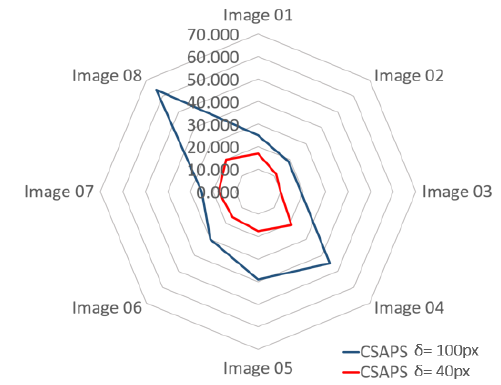
Figure 15: RMS localization error